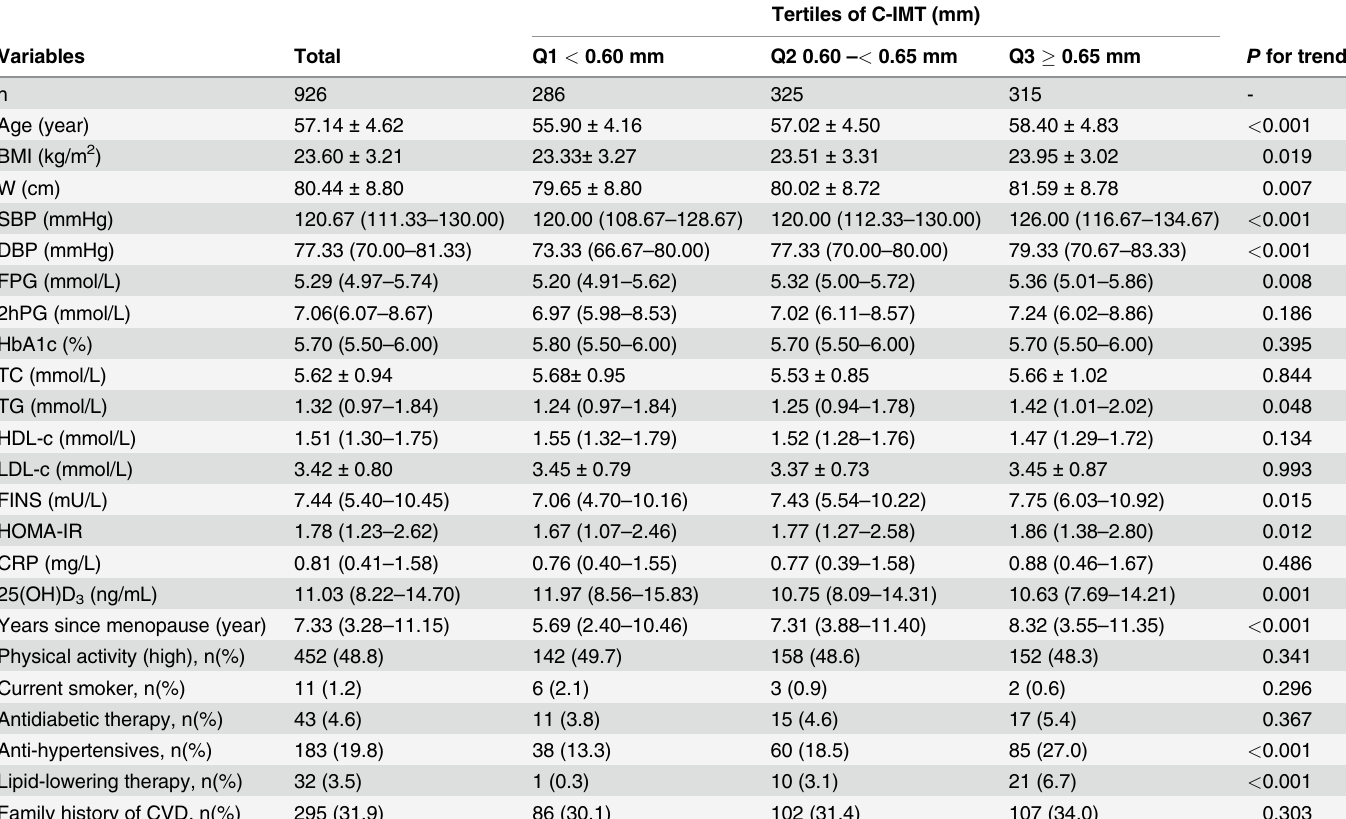
Table 1. Demographic and clinical characteristics of study